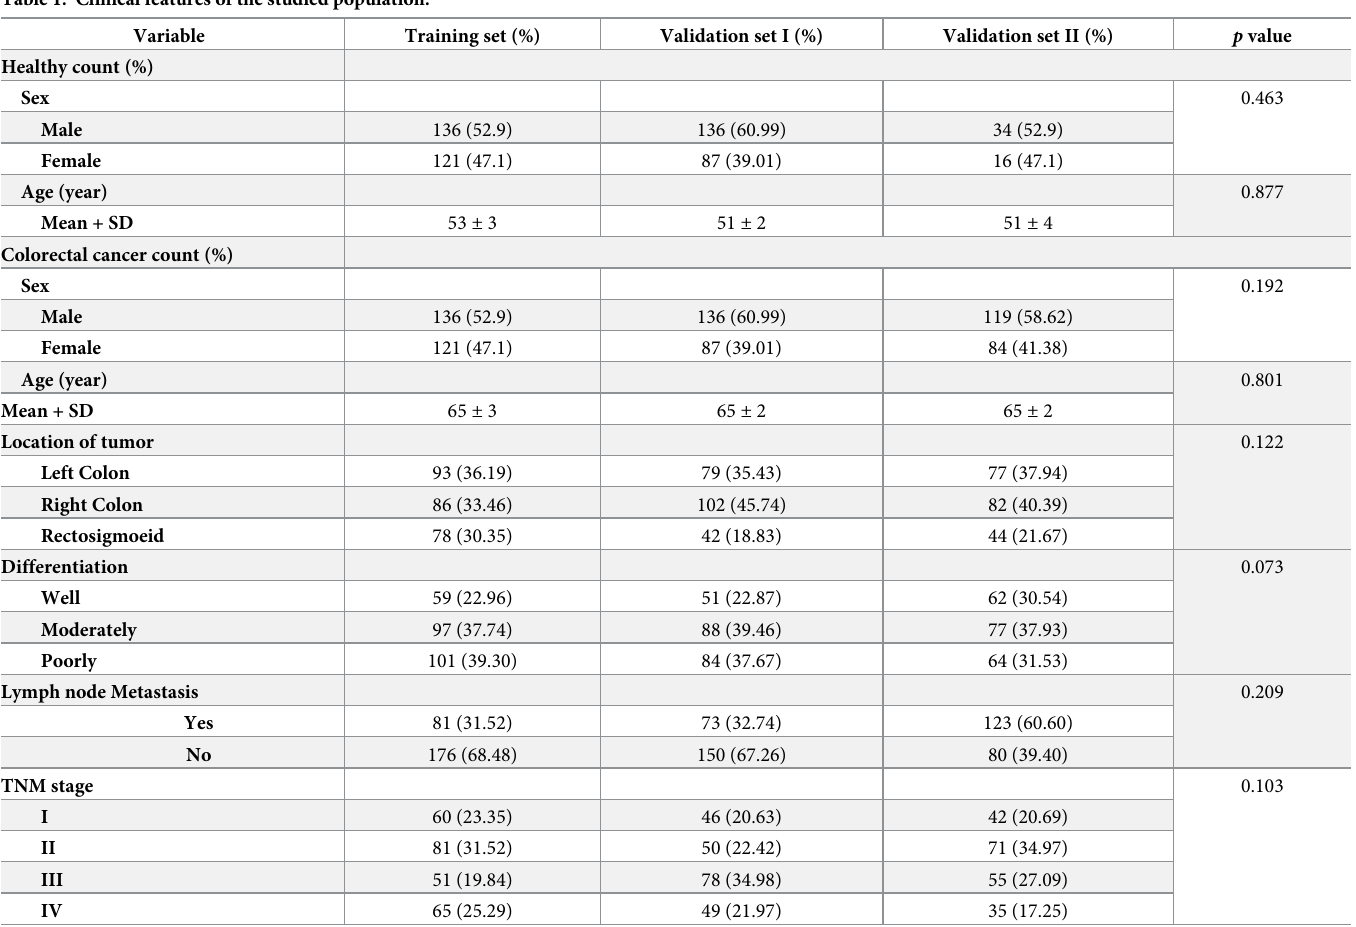
Table 1. Clinical features of the studied population.